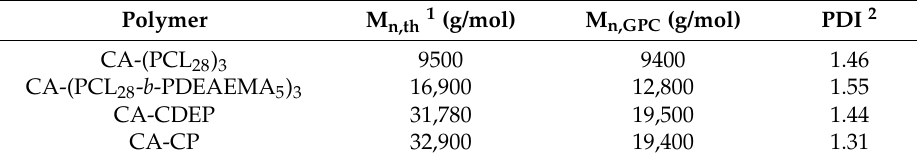
Table 1. Molecular weight measured by GPC and compared to the theoretical value.